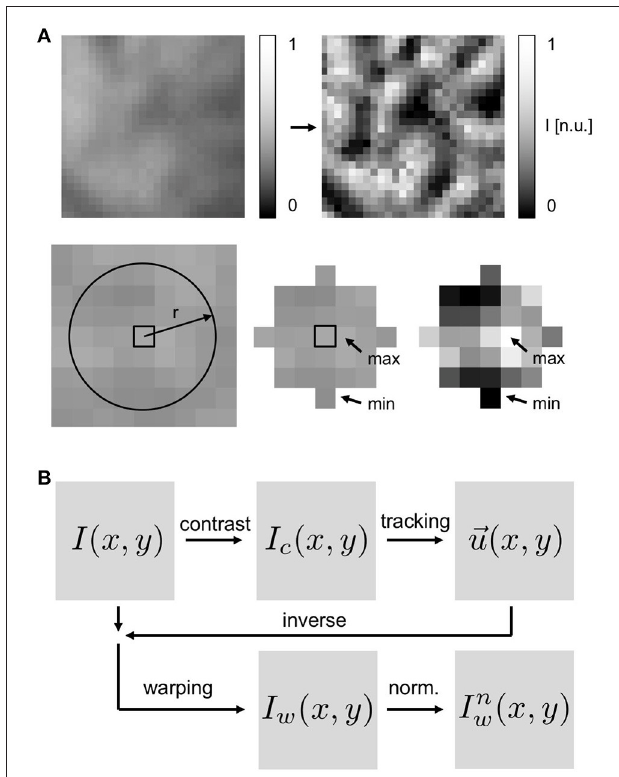
FIGURE 4 | Motion tracking using contrast-enhanced video images: (A) Top left image: original, raw video image with pixel intensities normalized to minimal and maximal values in entire video ( I ( x , y ) ∈ [0,1]). Top right image: contrast-enhanced video image used for motion tracking ( I c ( x , y ) ∈ [0,1]) with pixel intensities normalized by minimal and maximal value in local neighborhood (disk-shaped region S xy ) around each pixel. Resulting contrast-enhanced images show maximally intensified short-scale image gradients and suppressed large-scale image gradients. (B) Schematic of motion tracking procedure with tracking of contrast-enhanced images I c . The original video images I are deformed using the inverse tracking data −E u to obtain motion-stabilized or warped videos I w ( x , y , t ), which are then further post-processed, i.e., pixel-wise normalized ( I n w ).